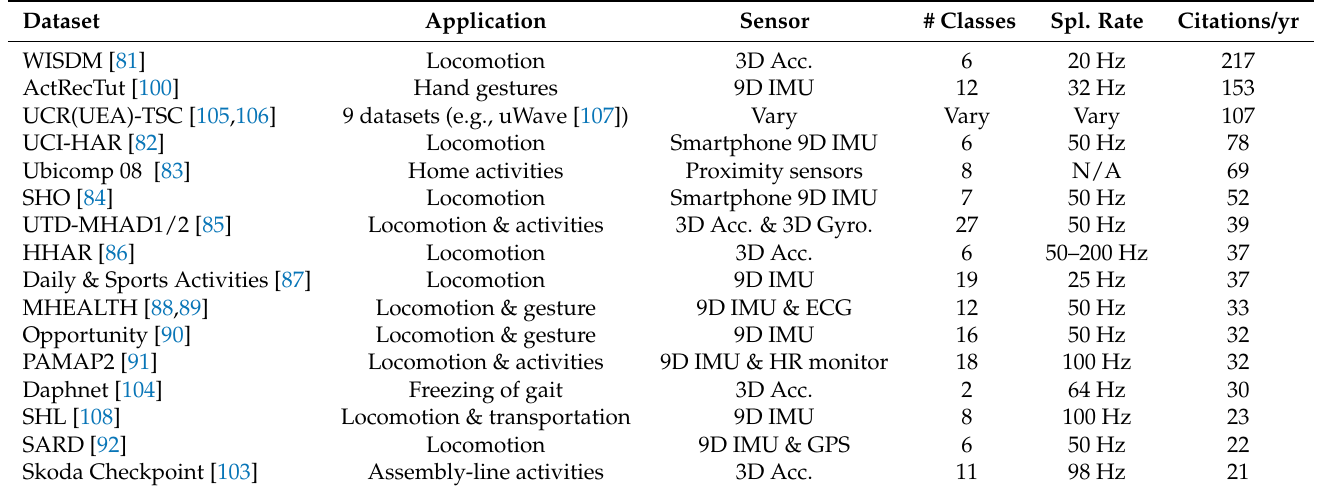
Table 1. Major Public Datasets for Wearable-based